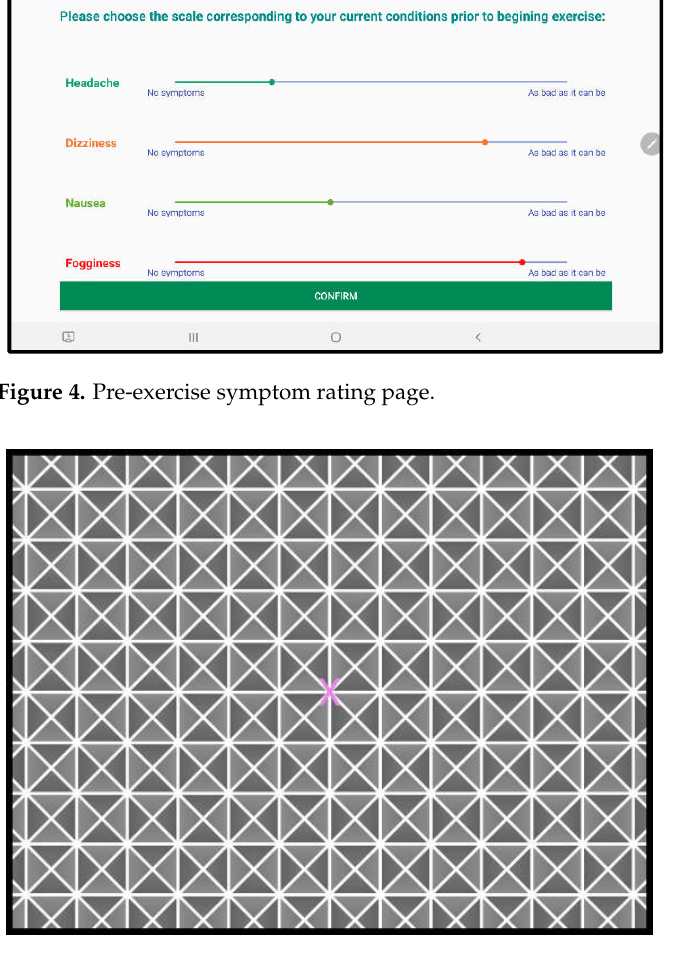
Figure 5. Exercise page (complex background).